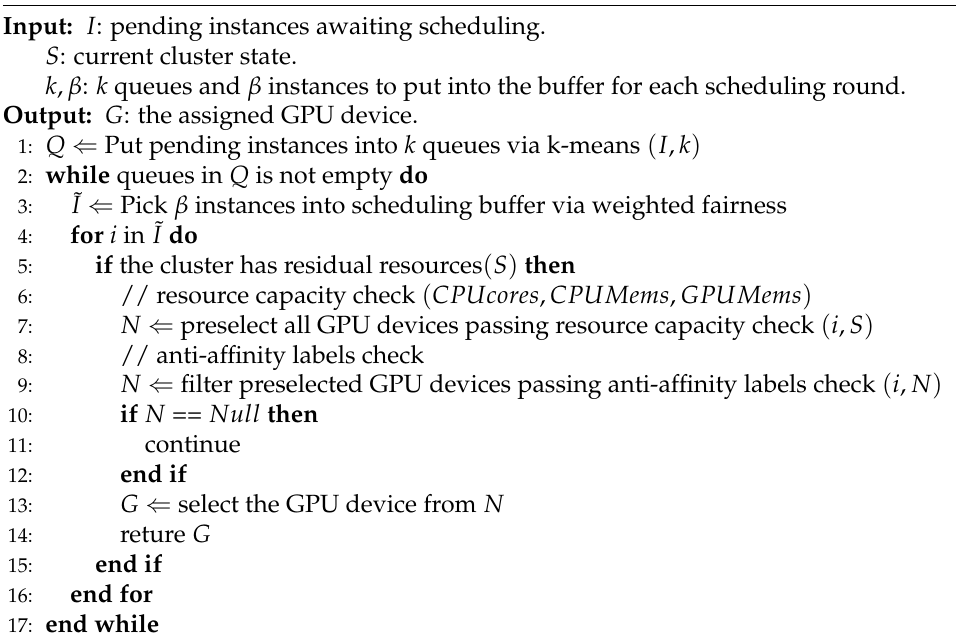
Algorithm 1 Resource-efficient instance